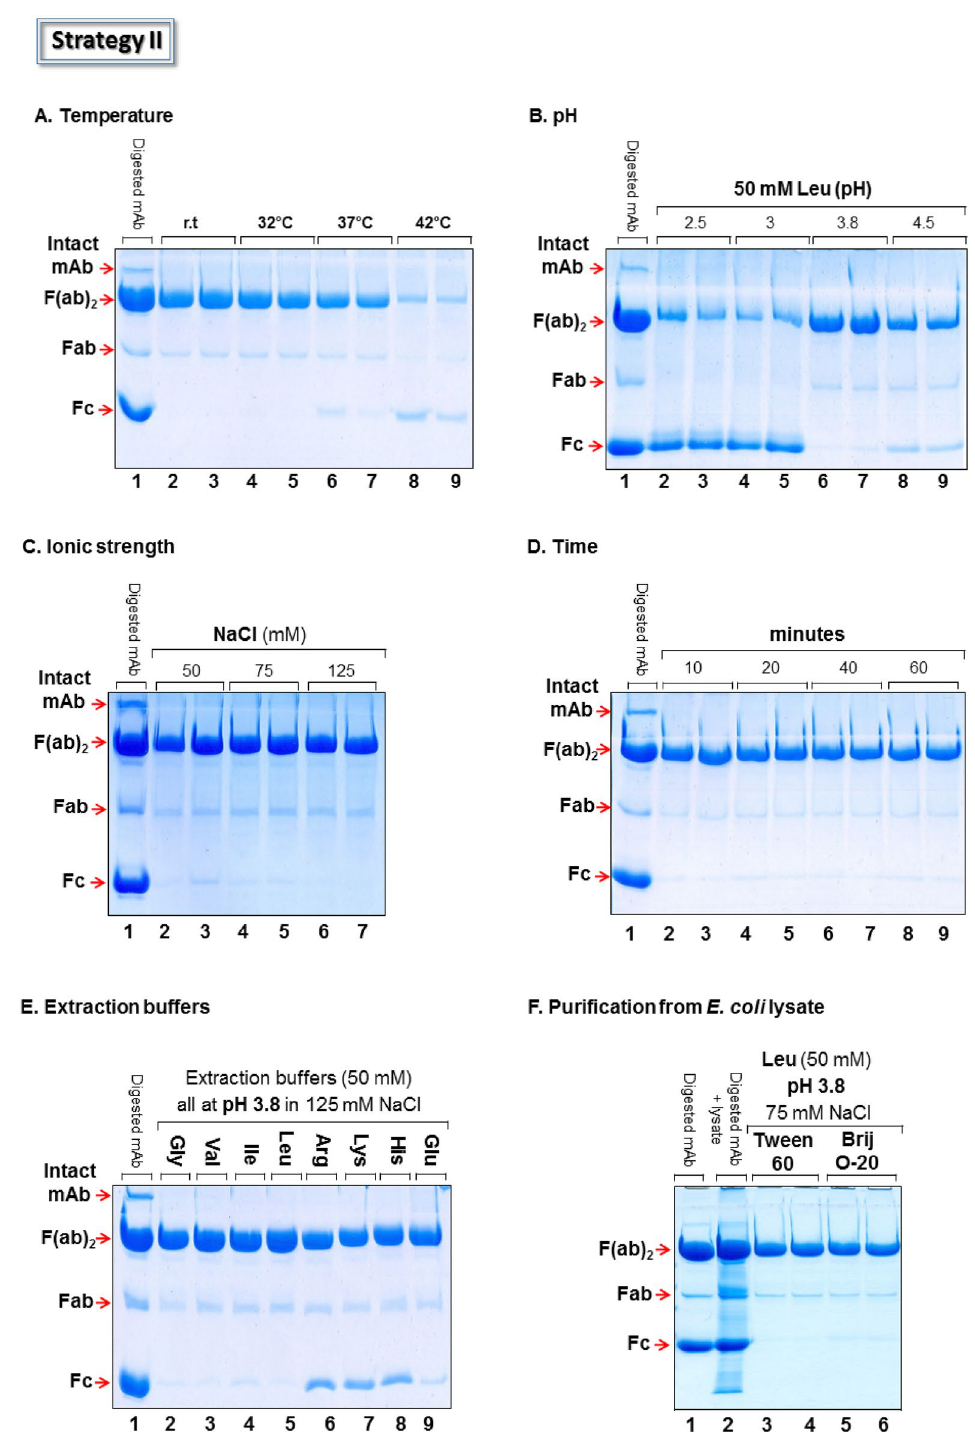
Figure 4. Parameters affecting Strategy II. ( A ) Effect of temperature on the extraction efficiency of Ab-fragments from Tween-60 aggregates at pH 3.8 in the presence of 50 mM leucine and 125 mM NaCl. ( B ) As in A, but at indicated pH values. ( C ) As in A, but at indicated salt concentrations. ( D ) As in A, but at pH 7.4, 13 mM NaCl and indicated time points. E As in A, but with indicated buffers and salt after 10 min at